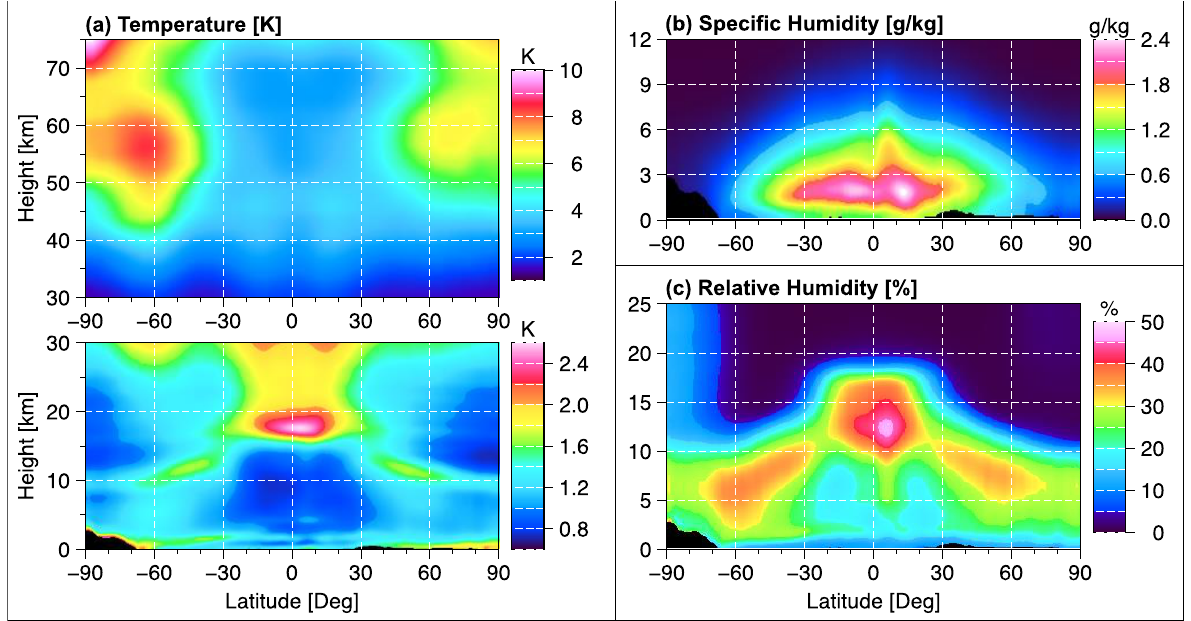
Figure 1. Meridional cross-section of annual-mean background error estimates: ( a ) temperature (°C), ( b ) specific humidity (g kg −1 ), and ( c ) relative humidity (%).